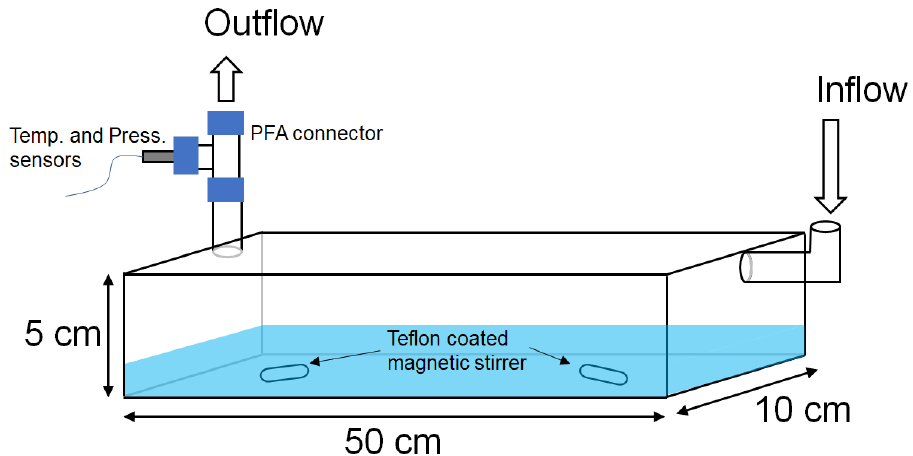
Figure 1. Schematic of the uptake experiment of gaseous elemental mercury (GEM) by a bulk solu- tion.